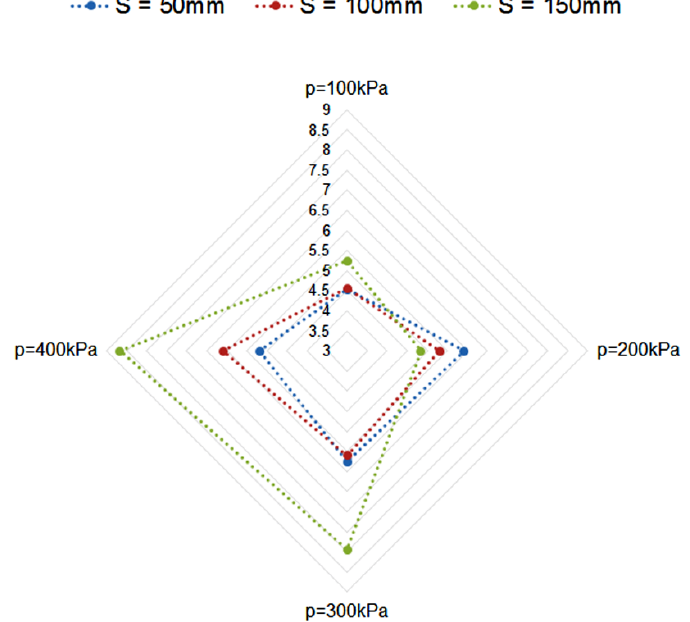
Figure 5. The ratio of retention (%) of the agent on the seed potato surface for the valve without electronic control, depending on the falling path distance (mm) (continuous flow).